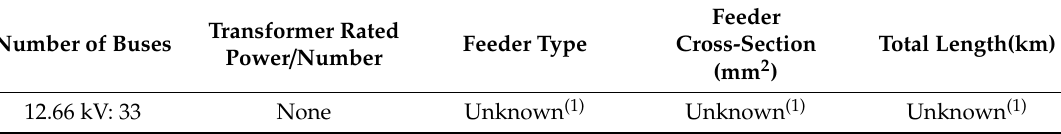
Figure 12. The residential 215-bus EDN. Table 4. The physical characteristics of the IEEE 33-bus system.